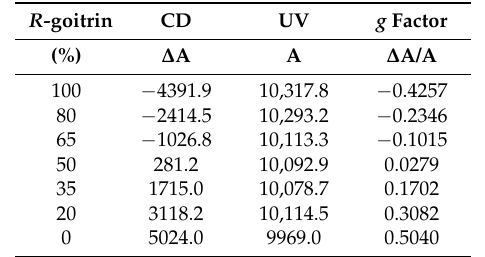
Table 2. The results of g factors from the different relative purities of R -goitrin using UV and CD detection.